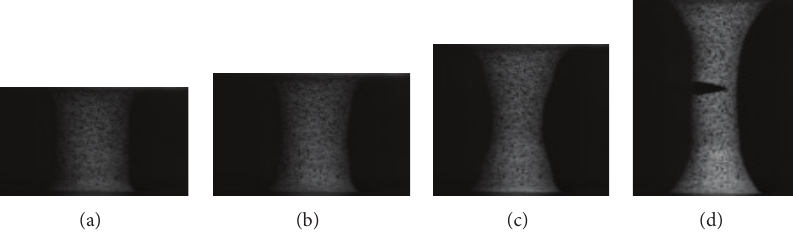
Figure 6: Deformation process during a 0.001/s strain rate experiment at (a) 19s, (b) 191 s, (c) 530 s, and (d) 1581s.